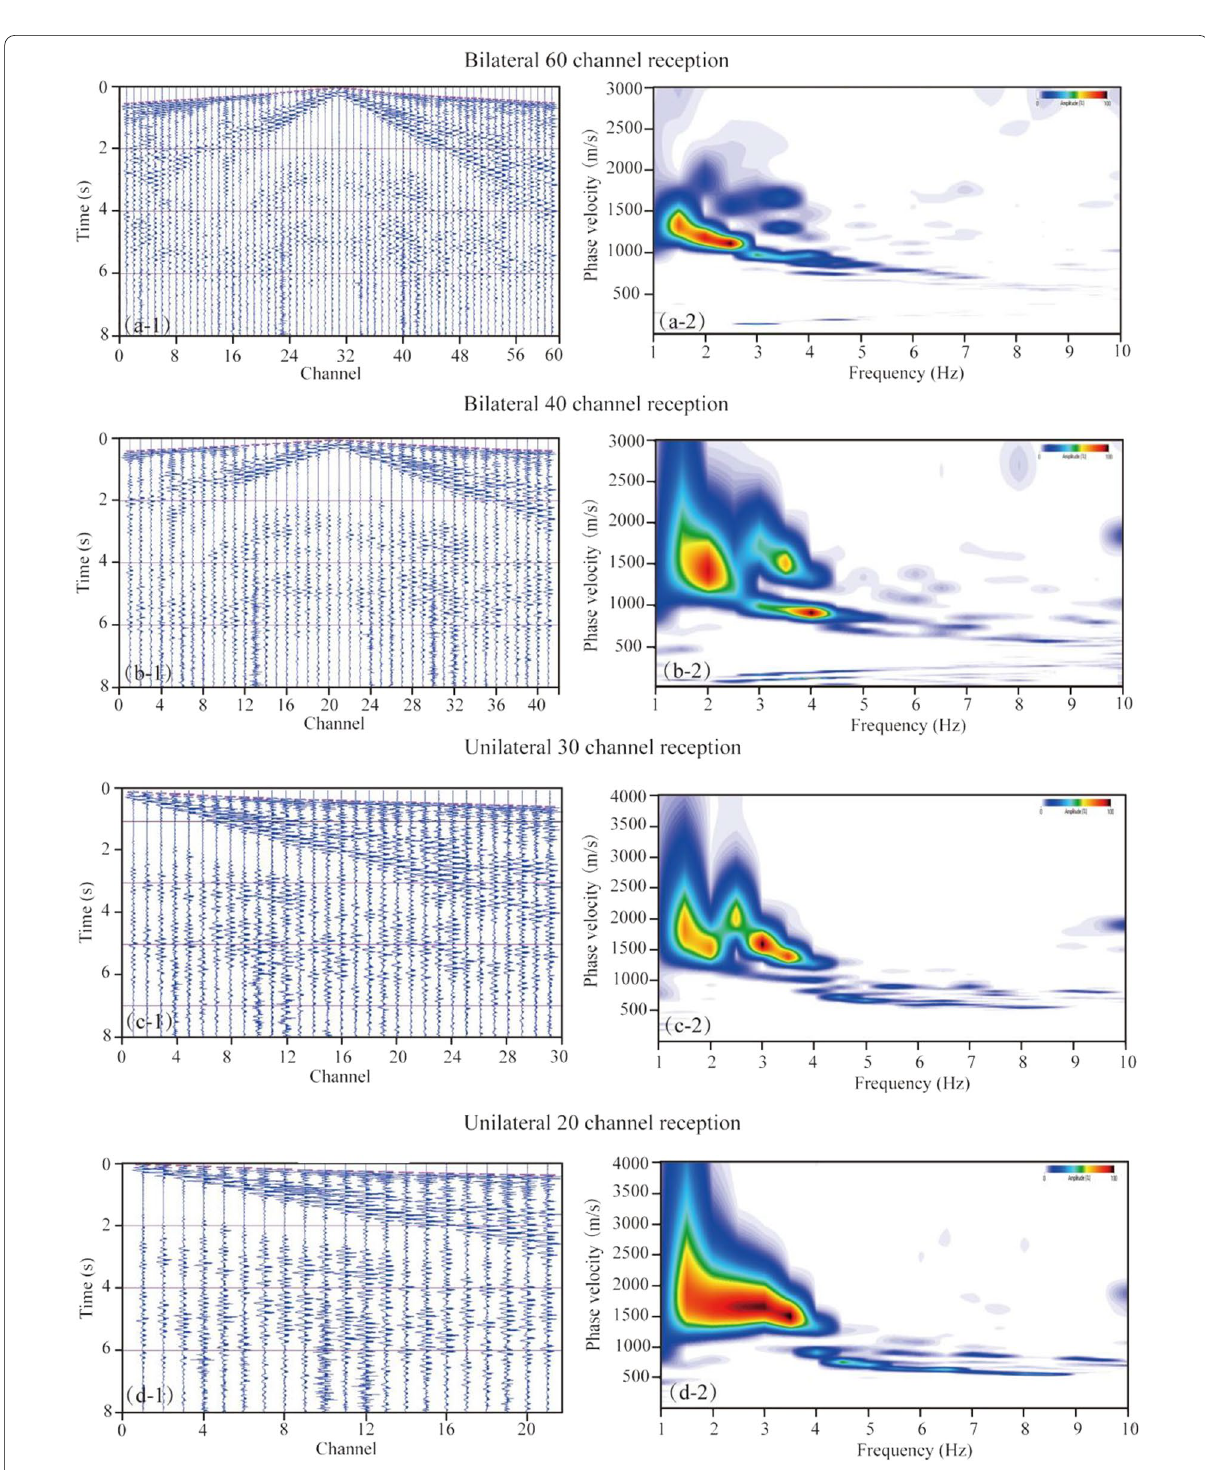
Fig. 4 Dispersion energy diagram of different reception modes. a Bilateral 60-channel reception. b Bilateral 40-channel reception. c Unilateral 30-channel reception. d Unilateral 20-channel